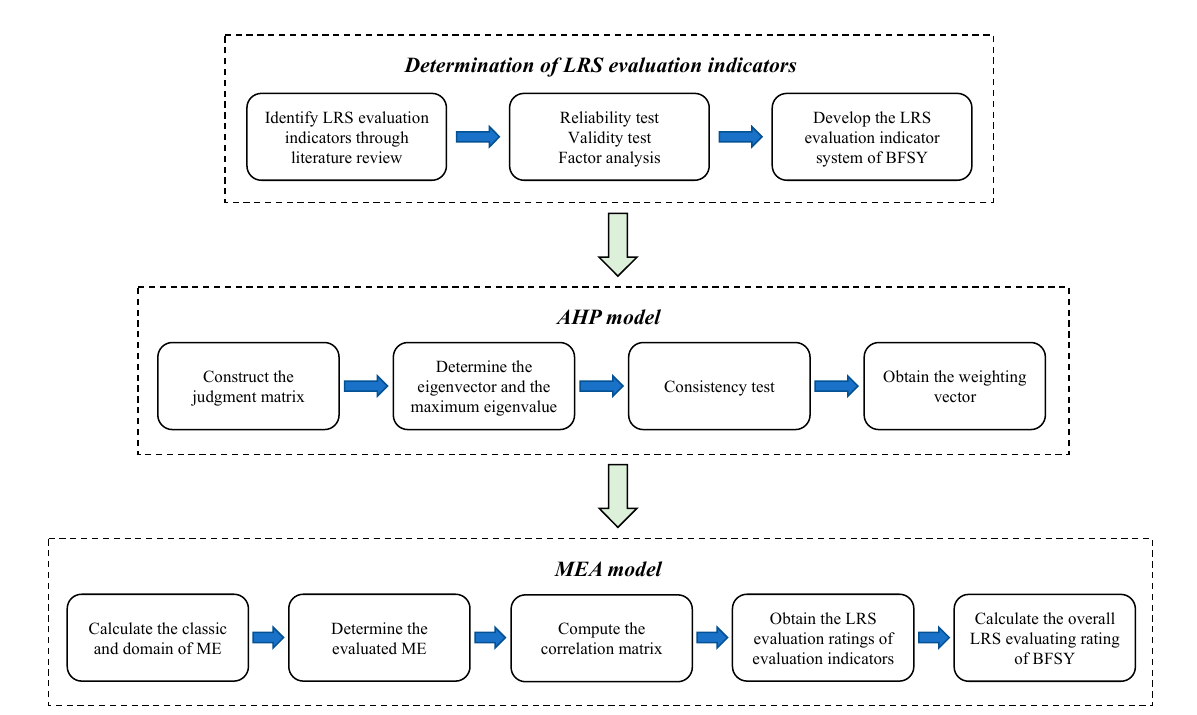
Figure 1. Methodology framework for evaluating the LRS of BFSY in railway construction.